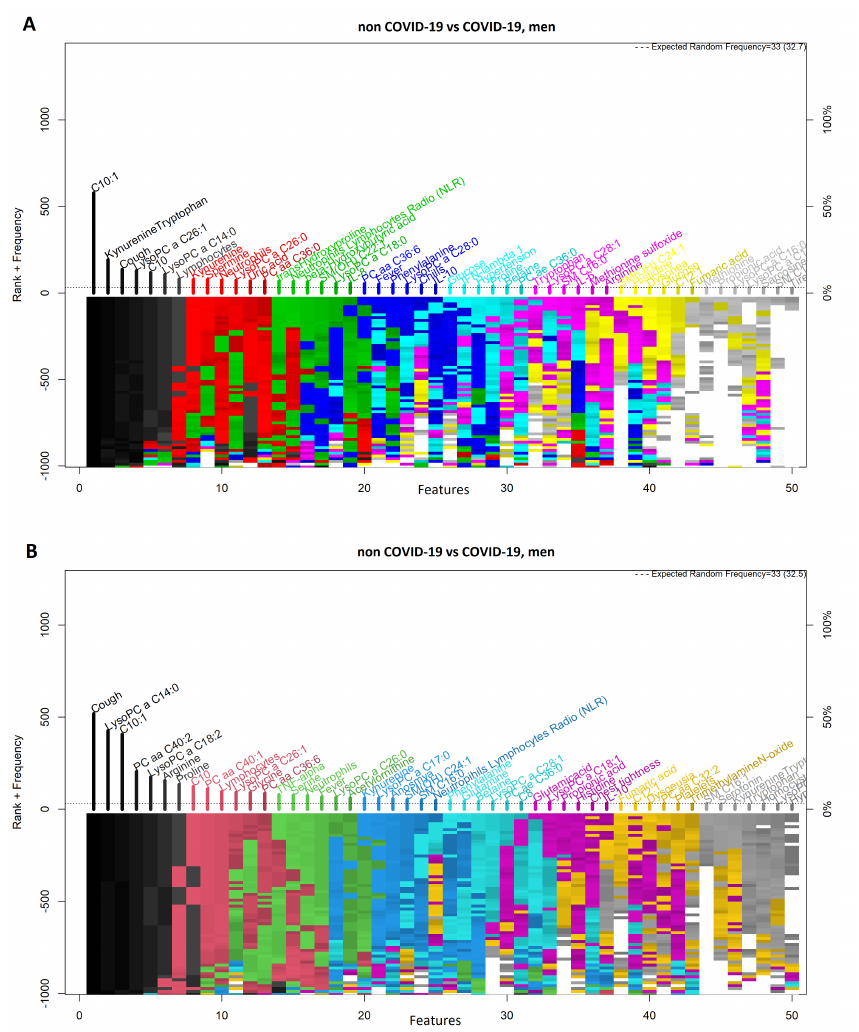
Figure 8. Feature–rank stability in 1000 models for the classification of men with and without COVID- 19. ( A ) Logistic regression model and ( B ) Support Vector Machine model. The ”y positive” axis shows the number of times each feature was included in a given model (the frequency ranking). The ”y negative” axis shows the color coded rank of each feature as each model was generated. The ”x” axis shows the features ordered by rank. The starting color for each feature is assigned accordingly to the feature descending rank (from black down to